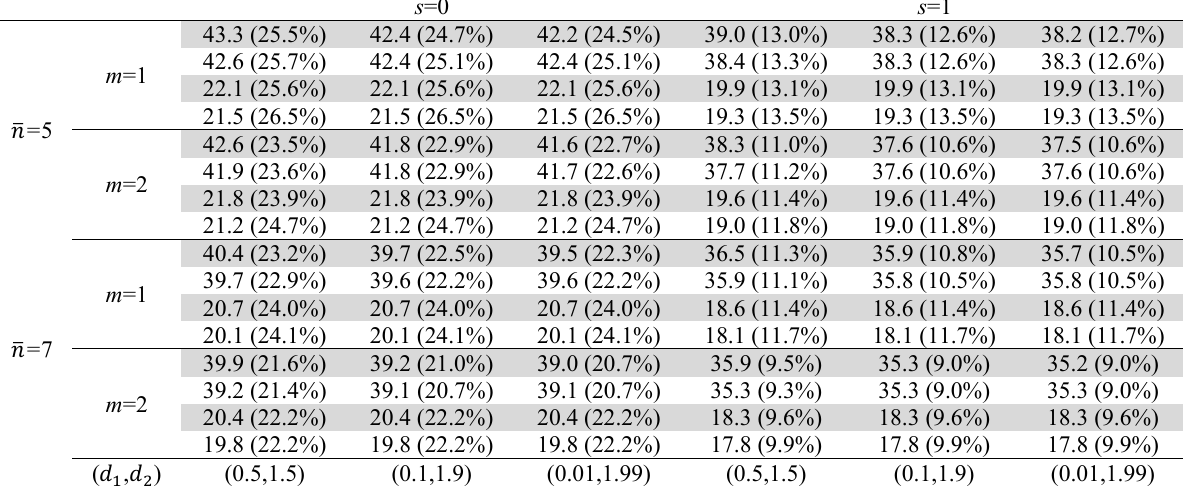
The EATS ( %Diff ), ESDTS ( %Diff ), EANSW ( %Diff ) and ESDNSW ( %Diff ) with the A SD AN SDN corresponding percentage difference (in brackets) from the i.i.d. case values for the steady-state VSSI-Synth and VSSI-Runs 𝑋(cid:3364) scheme when H =5, 𝑛(cid:3364) ∈ {5, 7}, 𝑑̅ =1, 𝜙 = 𝛾 = 0.5 and ATS 0 =370.4 s